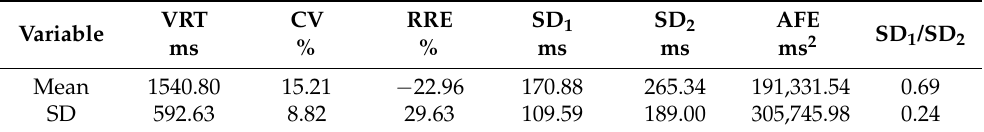
Table 3. Descriptive parameters of the experimental group, based on the VRT session of testing ( n =